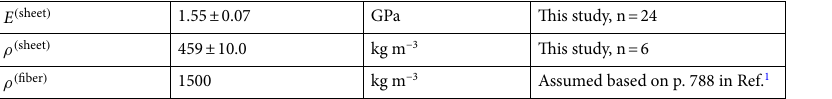
Table 1. Mechanical properties of tested handsheets and fiber density relevant to the Cox equation (Eq. 1). Measured properties are given as mean ± standard